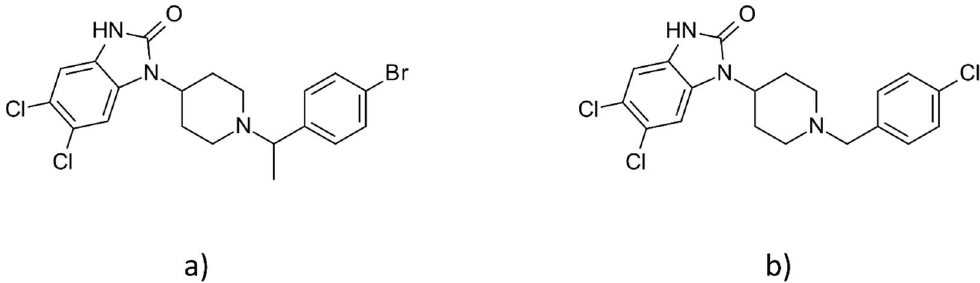
Figure 1. Chemical structures of ( a ) SR-14968 and ( b ) SR-17018.